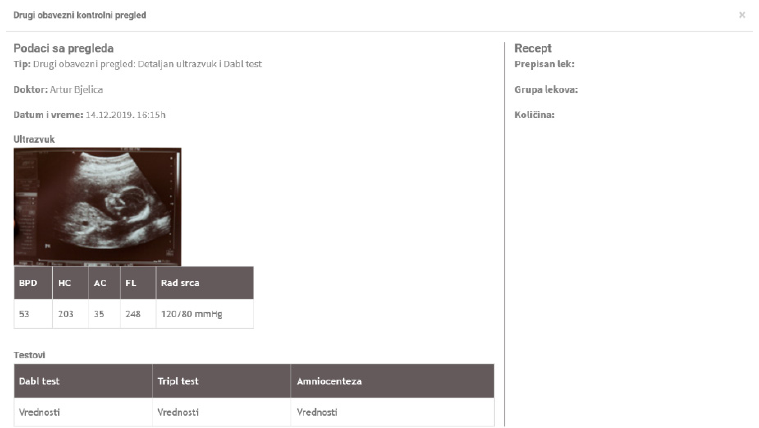
Figure 6. Web application — ultrasound results.